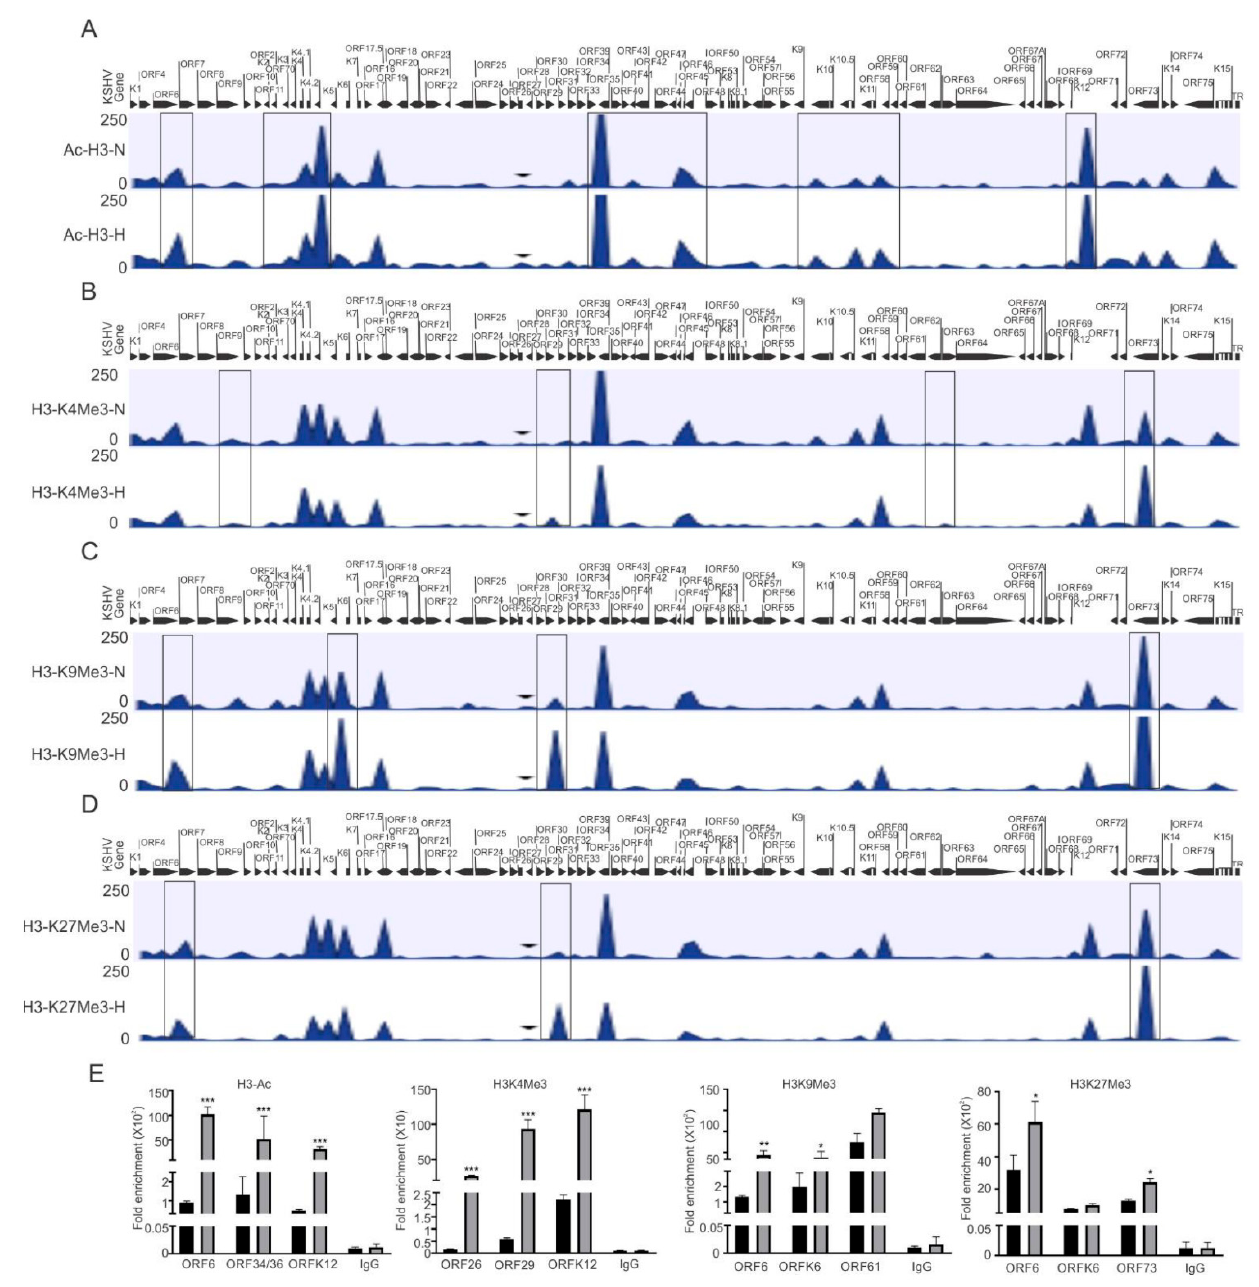
Figure 1. Differential enrichment of modified histone proteins on the KSHV genome during hypoxic reactivation. ( A ) The histogram for differential enrichment of AcH3 on the KSHV genome in normoxic and hypoxic conditions. ( B ) The histogram for differential enrichment of H3K4Me3 on the KSHV genome in normoxic and hypoxic conditions. ( C ) The histogram for differential enrichment of H3K9Me3 on the KSHV genome in normoxic and hypoxic conditions. ( D ) The histogram for differential enrichment of H3K27Me3 on the KSHV genome in normoxic and hypoxic conditions. A complete list of statistically significant enrichment region on the KSHV genome is provided as Supplementary File S1. ( E ) Validation of ChIP sequencing result using ChIP-qPCR. ChIP DNA was used to perform real-time PCR using primers specific to ORF6, ORFK6, ORF12, ORF26, ORF29, ORF34/36, ORF61, and ORF73 (N = Normoxia, H = Hypoxia). The p value of<0.05 was considered significant. NS, not significant; * p value < 0.05; ** p value < 0.01;*** p value < 0.005.